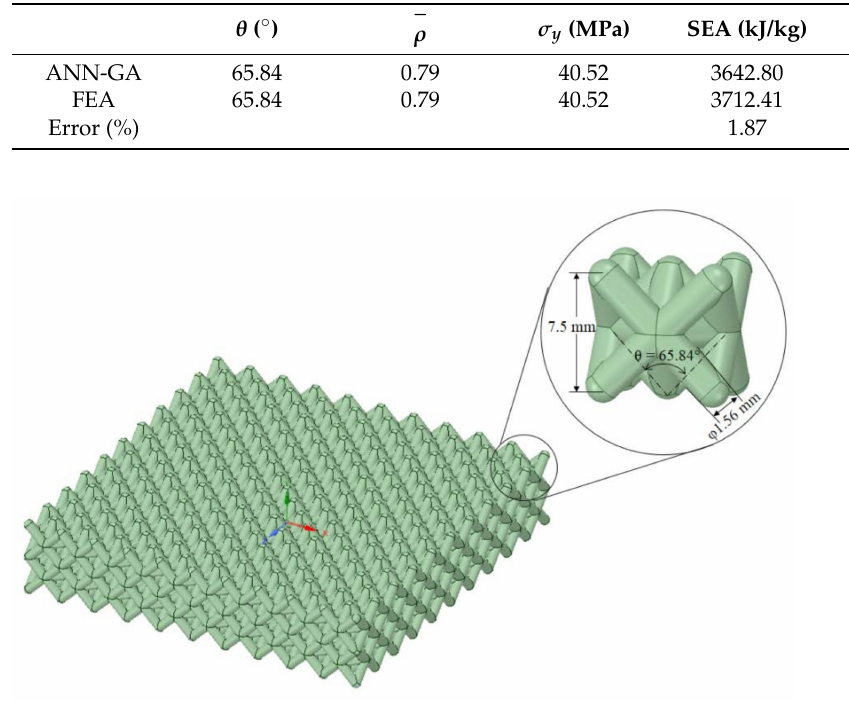
Table 6. Comparison of predicted and FEA results for the optimum configuration.